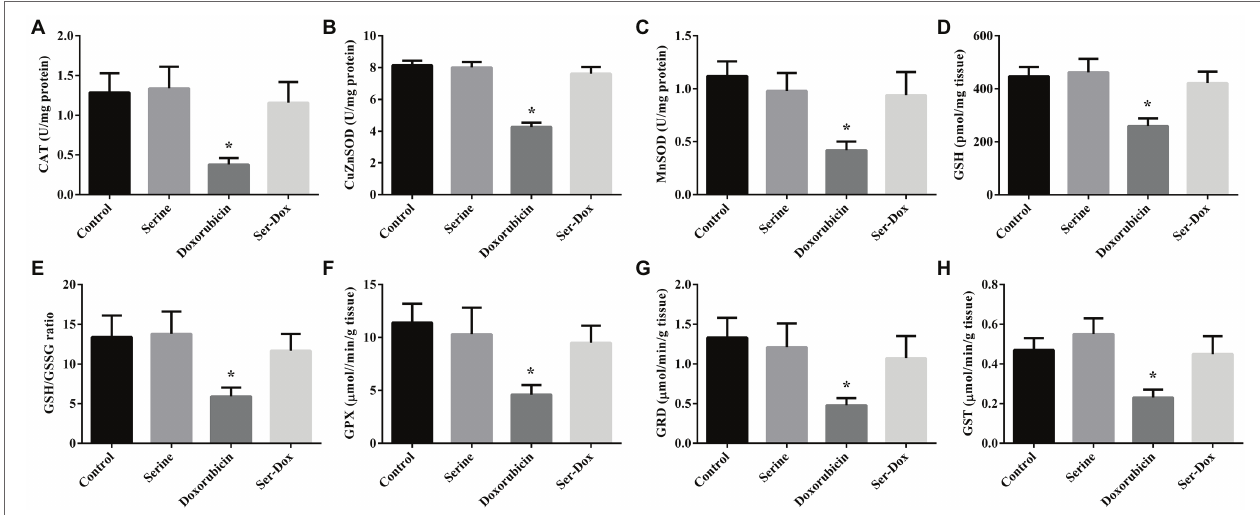
FIGURE 3 | The activities of antioxidant enzymes and glutathione content in the skeletal muscles of mice. CAT (A) , CuZnSOD (B) , and MnSOD (C) activities in the skeletal muscles; GSH content (D) , GSH/GSSG ratio (E) , GPX (F) , GRD (G) , and GST (H) activities in the skeletal muscles. Values are expressed as LSmean plus pooled SEM, n = 8. *Mean values were significantly different among groups ( p < 0.05). CAT, catalase; MnSOD, manganese superoxide dismutase; CuZnSOD, copper-zinc superoxide dismutase; GSH, reduced glutathione; GSSG, oxidized glutathione; GST, glutathione S-transferase; GRD, glutathione reductase; and GPX, glutathione